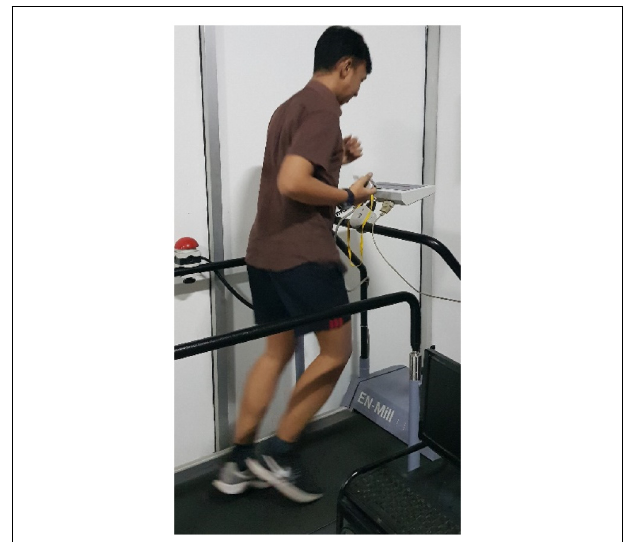
FIGURE 2 | Speed group participants using Polar H10 (Figure permissions had been approved by